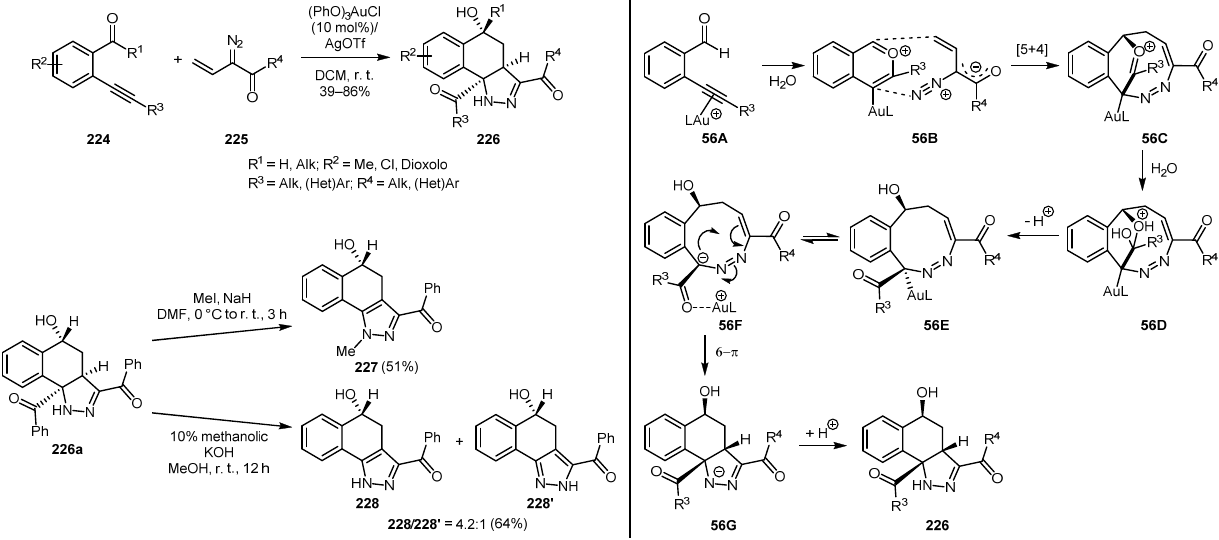
Scheme 56. Synthesis of 4,5-dihydro-benzo[ g ]indazoles by gold-catalyzed [5+4]-annulation between 2-alkynyl-1-carbon- ylbenzenes and vinyldiazo